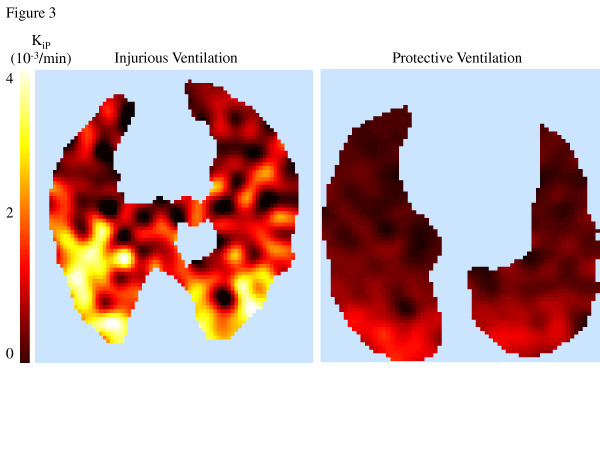
Single-slice images of 18F-fluorodeoxyglucose uptake rate. Single-slice images of 18F-fluorodeoxyglucose (18F-FDG) uptake rate (KiP, computed voxel-by-voxel using the Patlak method [31]) in one sheep from the protective ventilation group (right panel) and in one from the injurious ventilation group (left panel). Left side in each image corresponds to the left side in the animal. 18F-FDG uptake was lower and more homogeneous in the protective ventilation experiment.